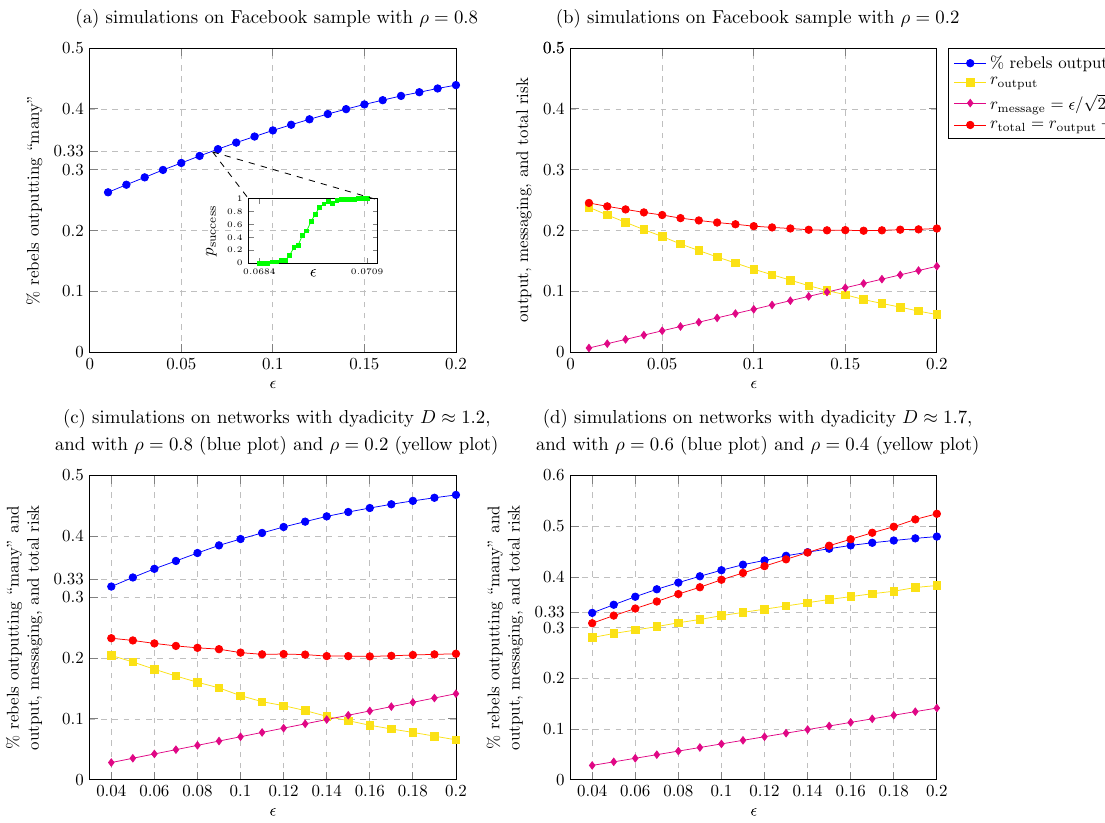
Figure 2. Public communication: Simulations of the Quorum-Sensing protocol on a Facebook network. We ran 10 times the Quorum-Sensing protocol on the sample of the Facebook social graph released in 28,29 (see “Methods”). The (average) percentage of rebels which output “many” when ρ = 0.8 (i.e, “many rebels”) is shown in ( a ). The inset in ( a ) represents the success probability in the interval between 0.0684 and 0.0709, that is, the probability that the percentage of rebels which output “many” is greater than 1 3 . The (average) risks of a rebel are depicted in ( b ). The r output value denotes the percentage of rebels which output “many” when ρ = 0.2 (i.e, √ 2 ; this latter value is, indeed, an upper bound on the message risk, as shown “few rebels”), while r message = ε/ in Lemma 1. Finally, r total is simply the sum of r output and r message (because of the previous observation, this is an upper bound on the total risk). ( c ) and ( d ) correspond to simulations on networks with different levels of homophily. Specifically, ( c ) corresponds to networks with dyadicity D ≈ 1.2 and ( d ) corresponds to networks with dyadicity D ≈ 1.7 . In ( c ), as usual, ρ = 0.8 represents the case of “many rebels” while ρ = 0.2 represents the case of “few rebels”. In ( d ), however, these values are replaced by 0.6 (for “many rebels”) and 0.4 (for “few rebels”); the reason for this exchange is explained in “Methods”. The semantics of the plots in ( c ) and ( d ) remain the same as in ( a ) and ( b